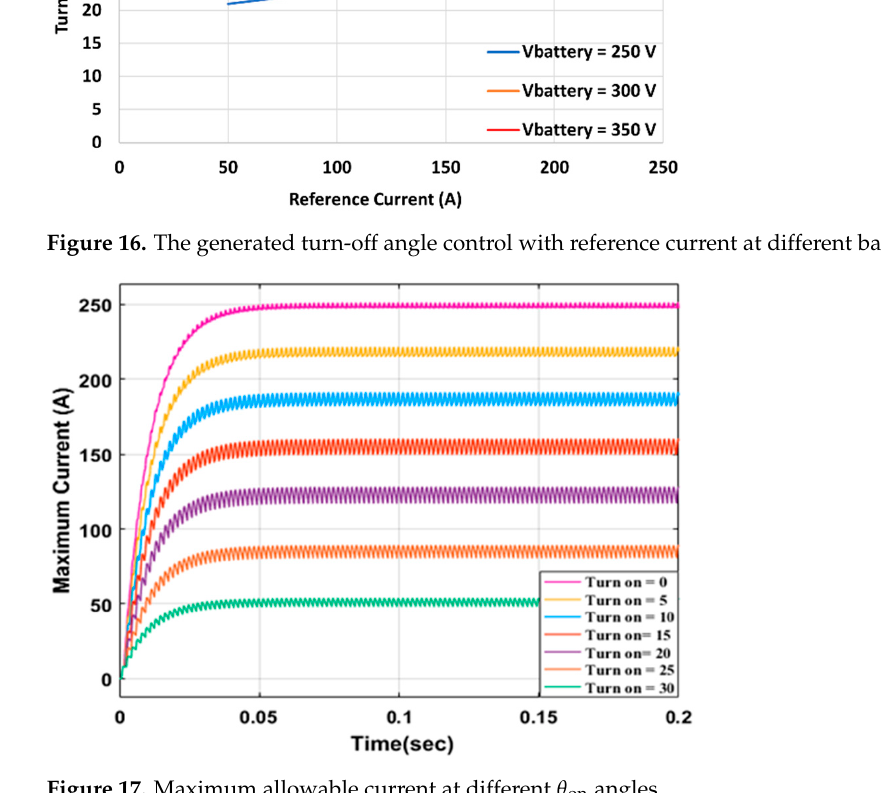
Figure 17. Maximum allowable current at different θ on angles.